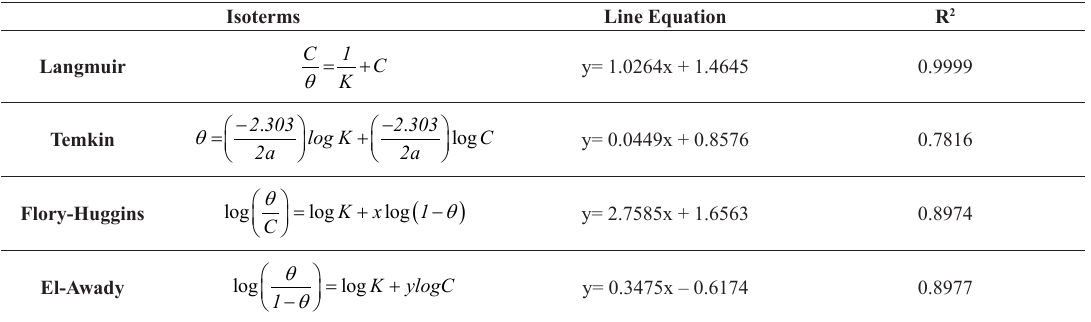
Figure 5. Bode diagrams of mild steel in 1 mol L −1 HCl in the absence and presence of different concentrations of ACSE and at 400 mg L −1 of its HMWF: (A) Phase angle vs. Frequency and (B) Impedance module vs. Frequency. Table 5. Data of straight lines obtained by linear